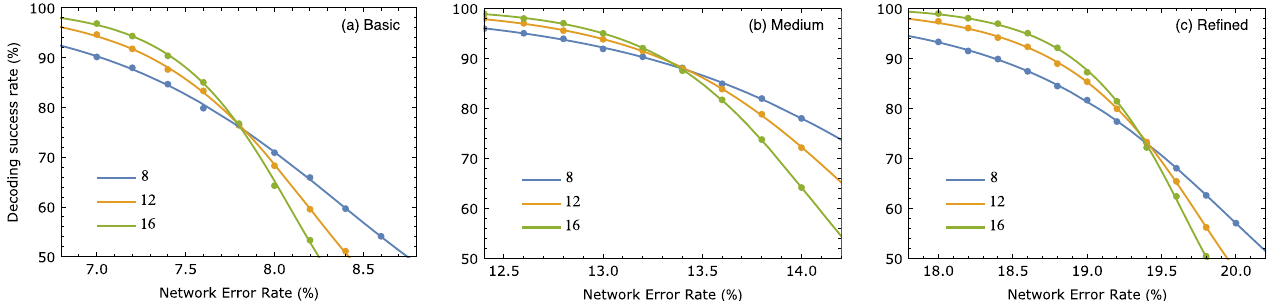
FIG. 4. Results of threshold calculations for the three protocols considered: (a) basic, (b) medium, and (c) refined. The logical error rate in the toric code is calculated for varying values of the network error rate p . The cells ’ internal error rates are taken to be the best n currently demonstrated in an ion trap system: a two-qubit gate error rate of 0.1% and a measurement error rate of 0.05% [1,2]. We select ⇒ r ≈ 1 p 1 ¼ 1 , and we take the phase shift in the EPL entanglement generation to be p , of 1%. Details of the error model can be 4 4 drift found in Appendix C. The three curves on each plot denote the results for increasing lattice sizes, where L ¼ 8 , 12, and 16 (therefore containing 2 L 2 data qubits). The threshold is defined as the intersection of these curves from which we find the basic protocol has a 7 . 7% , medium has a threshold of p 13 . 3% , and refined has a threshold of p 19 . 4% . In Appendix E, we further threshold of p n ¼ n ¼ n ¼ explore the dependence of the network error threshold on the error rates for intracell two-qubit gates and